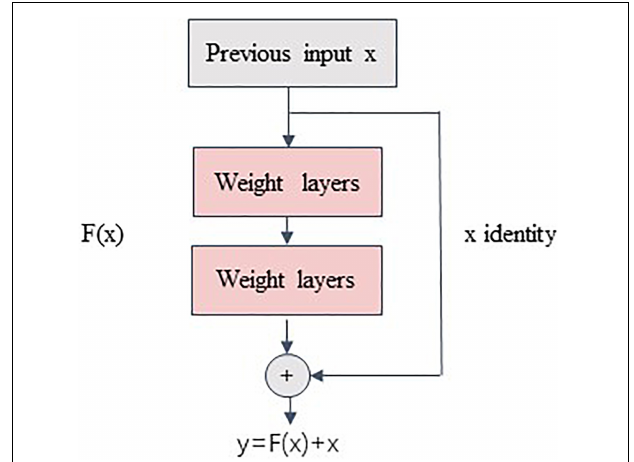
FIGURE 3 | Residual block. The ResNet’s Core